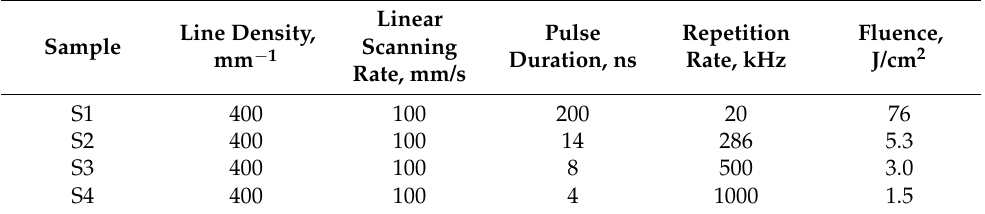
Table 1. Parameters of laser treatment for samples studied in this